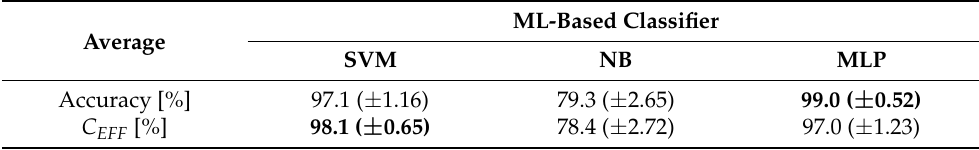
Figure 22. The average accuracy and C EFFs together with the standard deviations of the analyzed models. Table 4. The comparison of the average accuracy and C EFF with standard deviation of the analyzed ML based ML based classifiers.